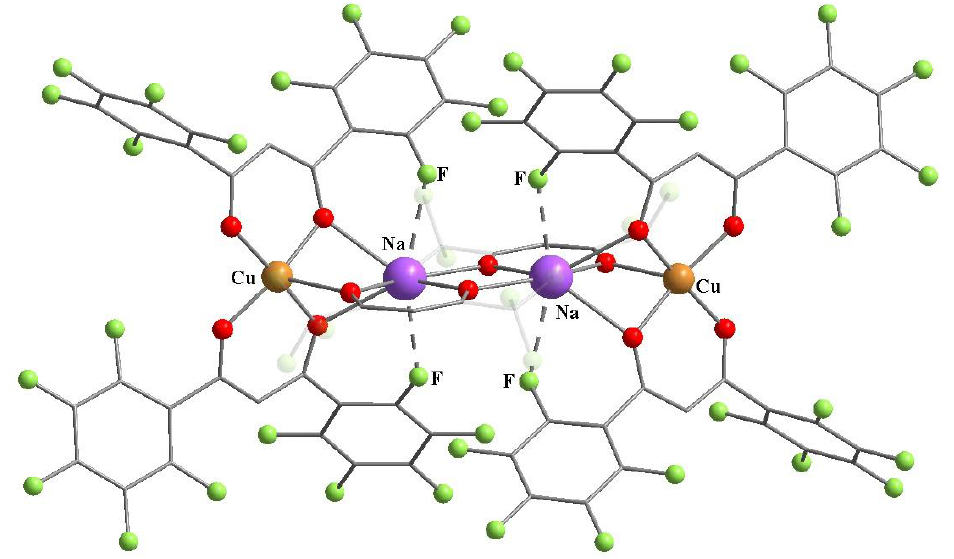
Figure 11. Molecular structure of 22 [64]. Hydrogen atoms have been omitted, CF 3 groups of hfac are transparent for clarity. The cif has been retrieved from CCDC. CCDC number is 1850164.